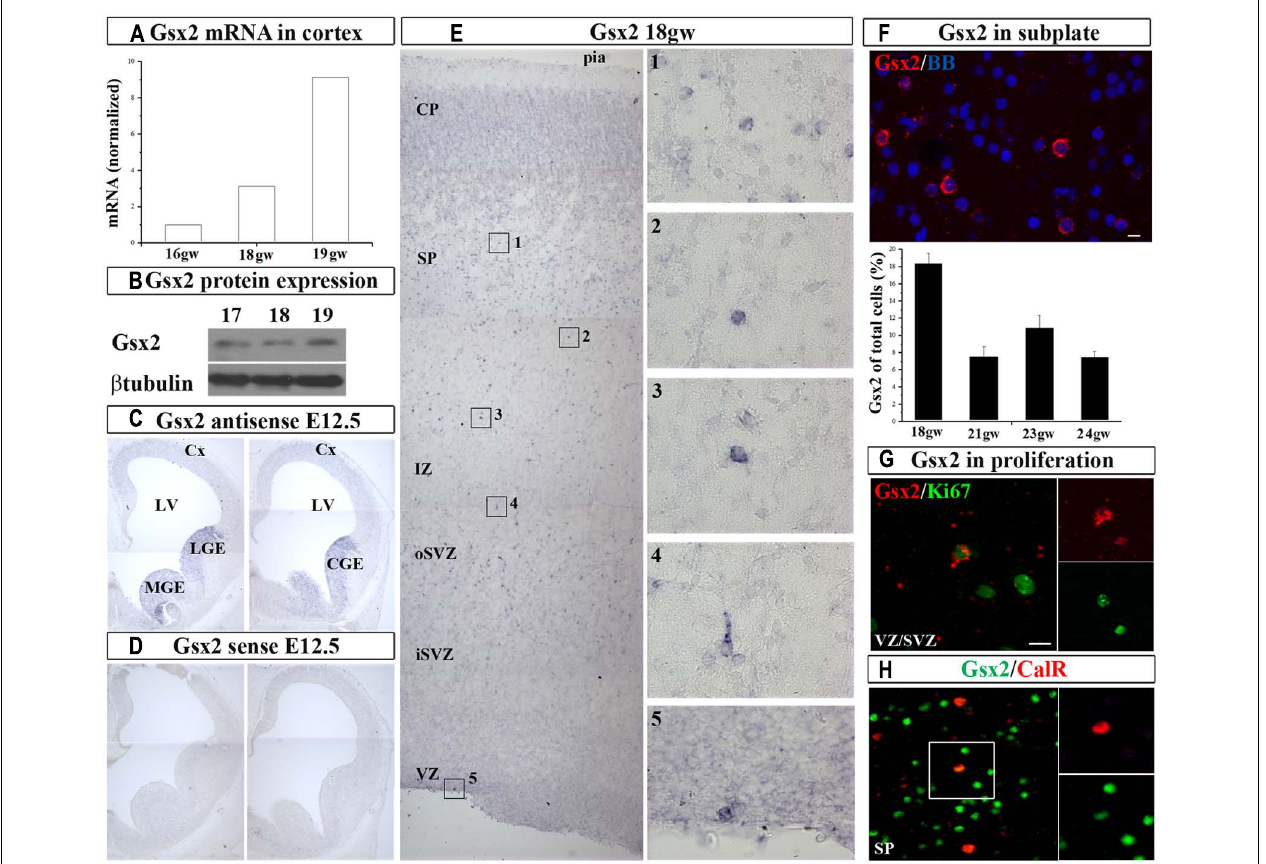
FIGURE 1 | Gsx2 in the human and mouse developing brain at mid-gestation. Expression of Gsx2 mRNA (A) and protein (B) in the human fetal cortex. In situ hybridization in E12.5 mouse with Gsx2 anti-sense (C) and sense (D) probe. (E) ISH in human fetal cerebral cortex (18 gw); insets- high magnification of Gsx2 + cells; (F) Representative Gsx2 + cells in subplate (FISH) for quantification (23 gw); percentage of Gsx2 + cells from total cells is shown in the histogram in the different